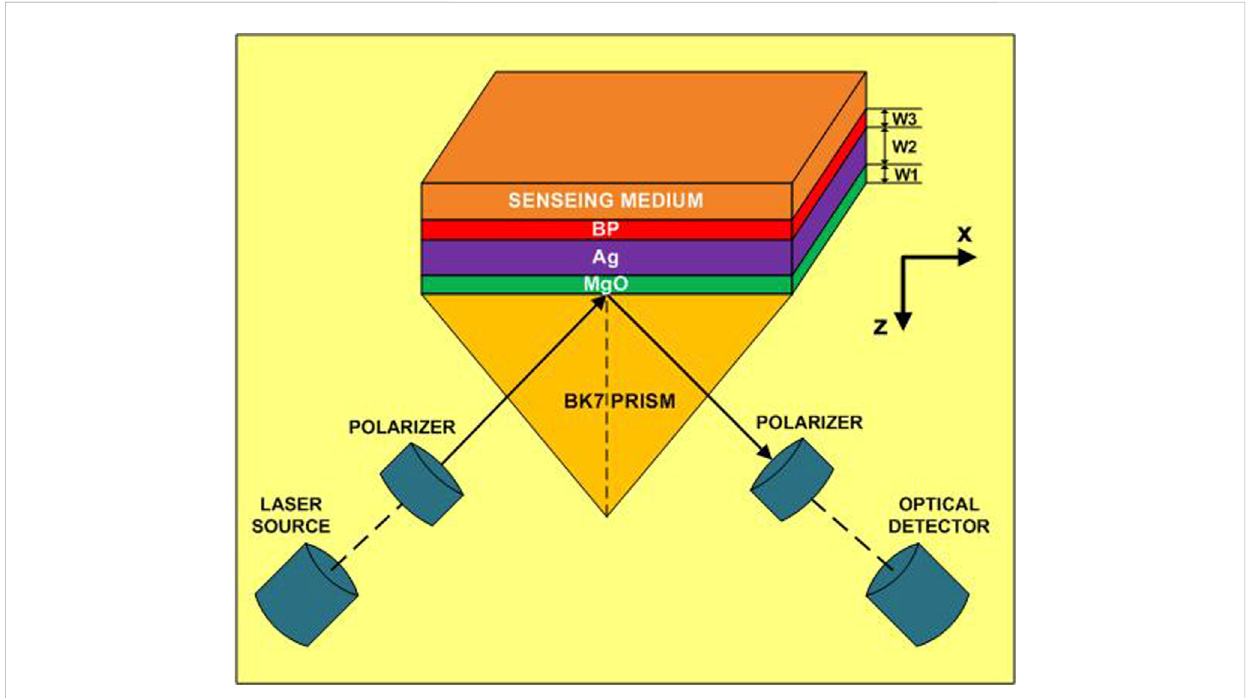
FIGURE 1 A fi ve layered proposed structure for SPR biosensor based on Kretschmann con fi guration. The thickness of the layers of MgO, Ag, and BP are denoted by W1, W2, and W3 respectively.